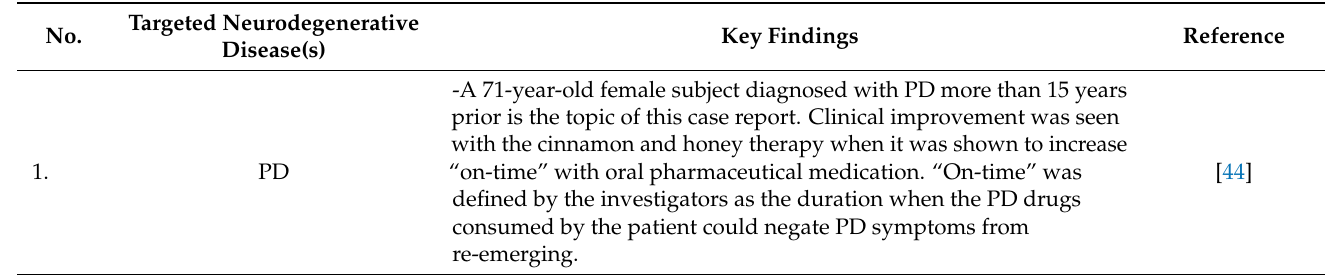
Table 4. Intervention study on the use of honey for the therapy of neurodegenerative diseases.